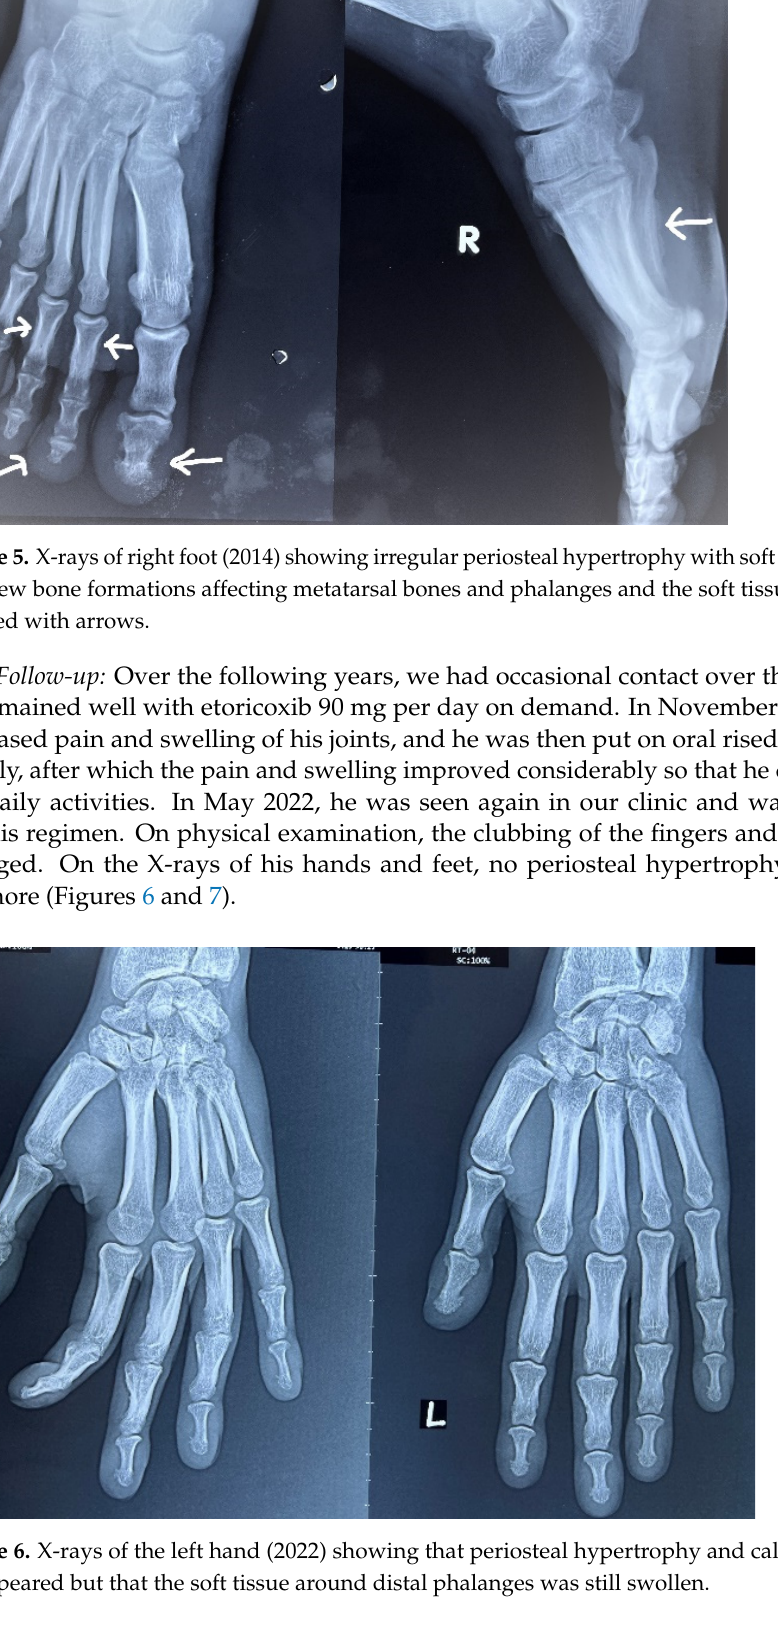
Figure 7. X ray of the feet (2022) showing that the periostal hypertrophy and calcifications had dis- appeared, but that the soft tissue around the distal phalanges was still swollen. 3. Discussion As far as we know, this is the second patient with pachydermoperiostosis (PDP) de- scribed in Bangladesh, with almost 170 million inhabitants. The first case regarded a 25- year-old male, published in 2017 [4]. PDP is also called Touraine–Solente–Golé syndrome or primary, or idiopathic, hypertrophic osteoarthropathy (HOA). Secondary HOA, as seen in patients with pulmonary or cardiac disease, is much more common, and the primary form accounts for only 3–5% of all HOA cases [5]. The clinical manifestations of PDP may vary. In some cases, the skin abnormalities may be prominent, while in others, the club- bing and joint complaints prevail.